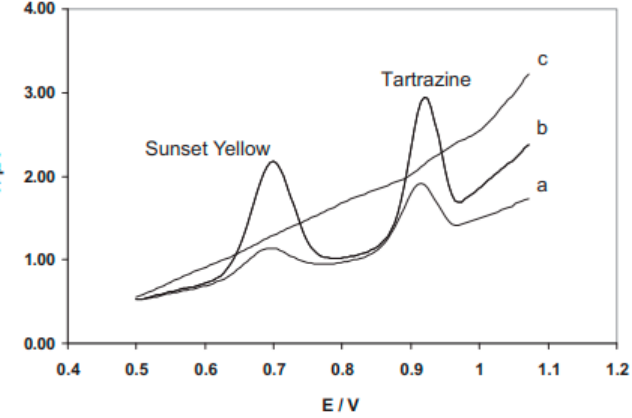
Figure 7. DPVs of 9.9 × 10 − 7 mol L − 1 SY and 5.0 × 10 − 7 mol L − 1 TZ at CPE (curve a) and nano Au-CPE (curve b). Curve (c): blank DPV of CPE. Accumulation time: 1 min. Reprinted with the permission of Reference [30]. [License Number 5067500229498]. Table 4. Table showing Sunset Yellow and Tartrazine detection using carbon paste electrodes with different modifiers along with their detection limits. S.No.